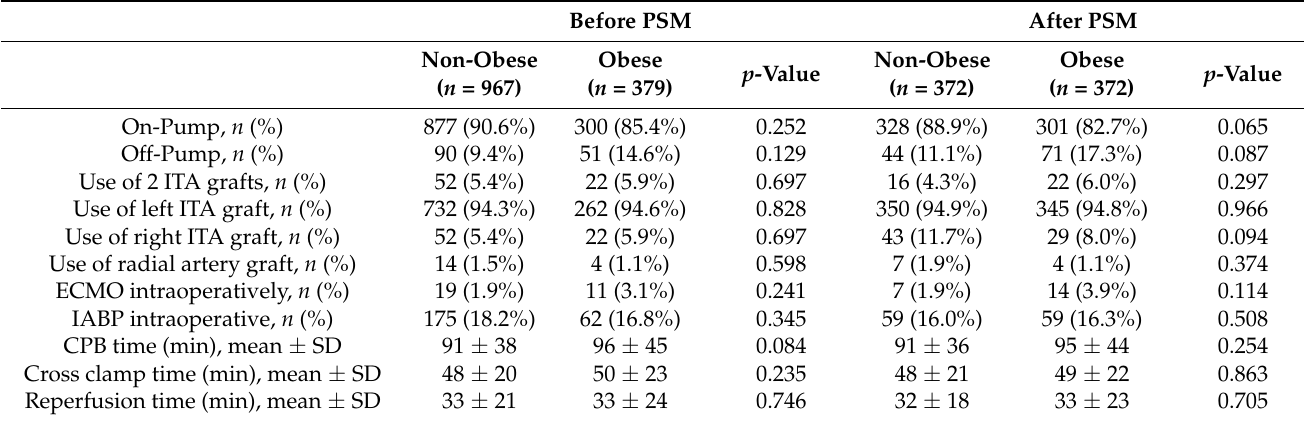
Table 2. Intraoperative data ( n = 1346 before PSM and n = 744 after PSM). Before PSM